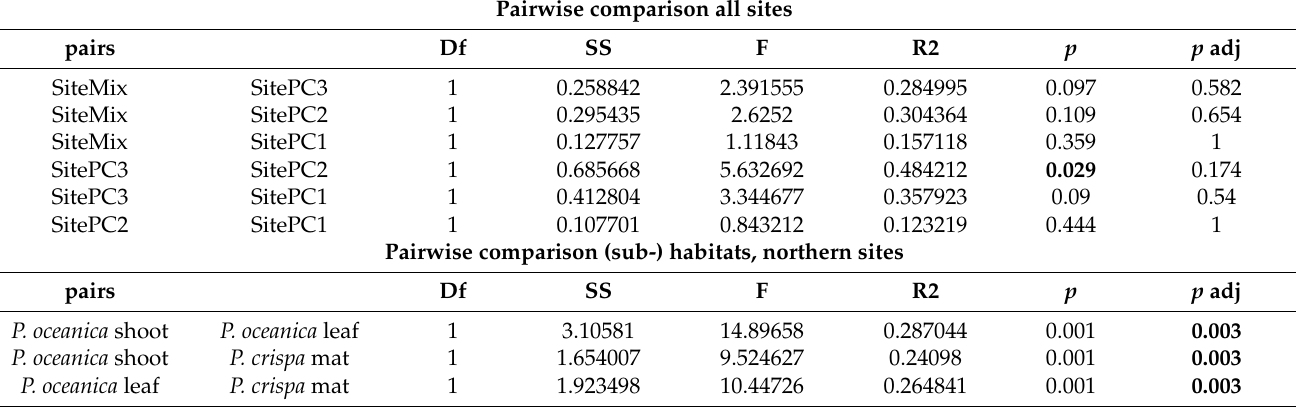
Table A1. Cont. Pairwise comparison all sites